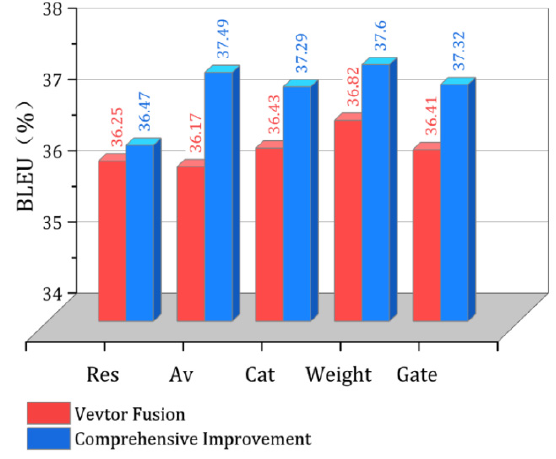
Figure 5. Comparison of experimental results. Table 3. BLEU value of comprehensive improvement